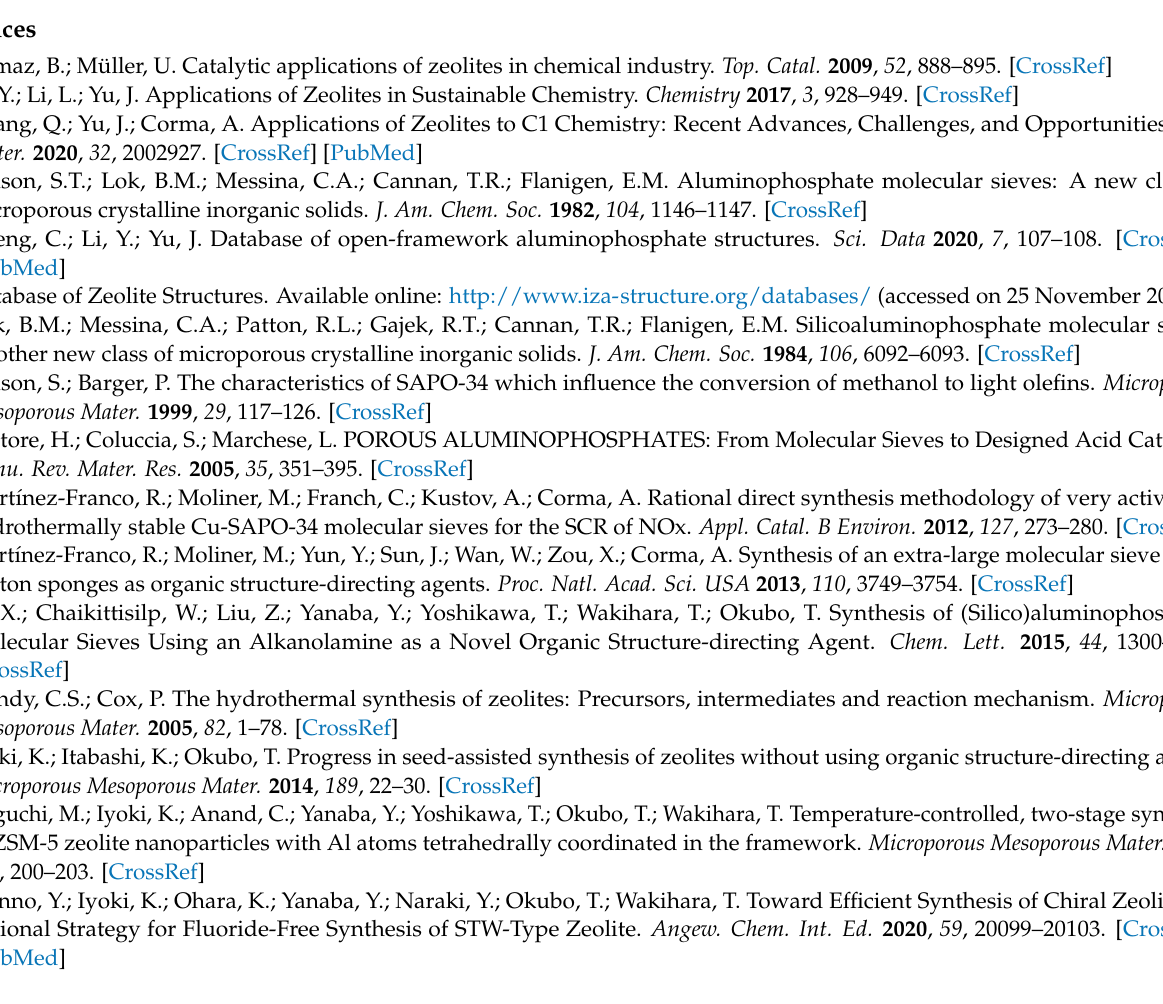
Table S1. Chemical analysis of the samples obtained at 150 ◦ C for different time using the synthesis gel composition 1.6 DIPEA: 0.60 SiO 2 : 1.0 Al 2 O 3 : 0.90 P 2 O 5 : 50 H 2 O. Table S2. Chemical analysis of the samples obtained at 150 ◦ C for different time using the synthesis gel composition 1.6